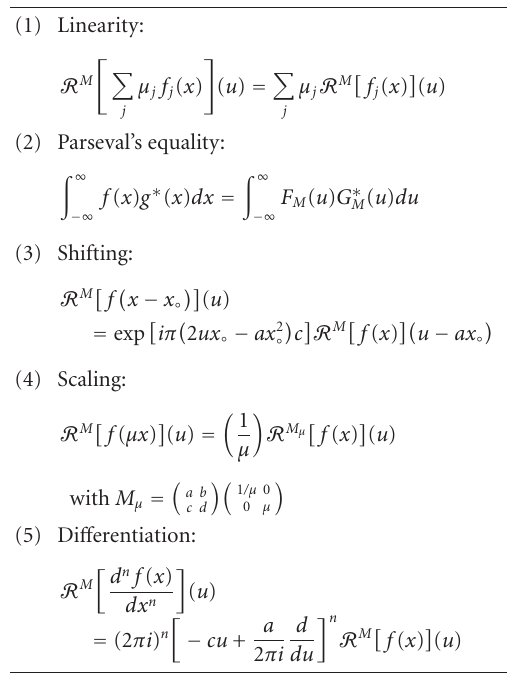
Table 1: Canonical integral transform: main